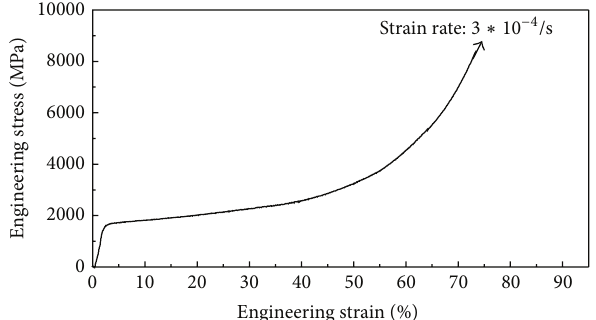
Figure 5: The compressive stress-strain curve of the Pd 81 Si 19 BMG deformed at room temperature.